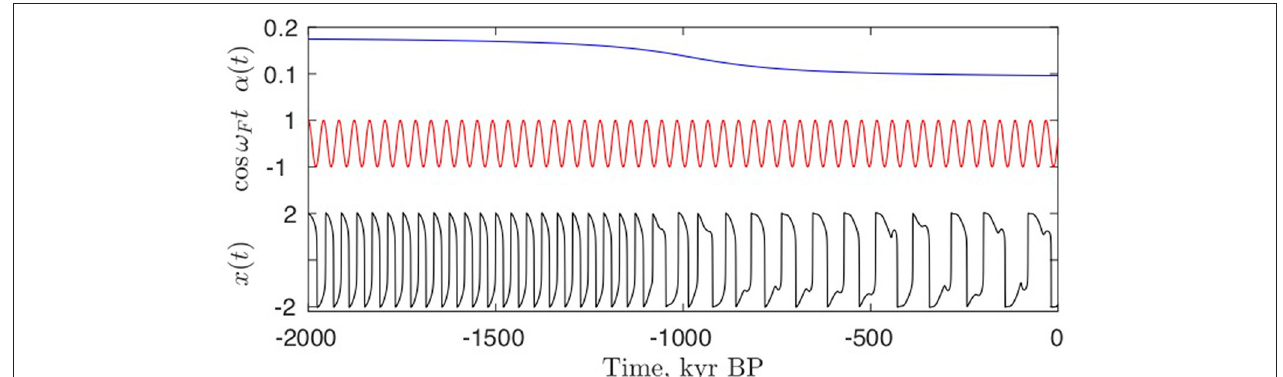
FIGURE 8 | By a slow change of the parameter α ( t ) the van der Pol oscillator (3) moves from a 1:1 synchronization tongue via a 2:1 to a 3:1 synchronization. The time scale is adjusted to the paleoclimatic time scale in Figure 4 . The forcing frequency is 41 kyr corresponding to the obliquity